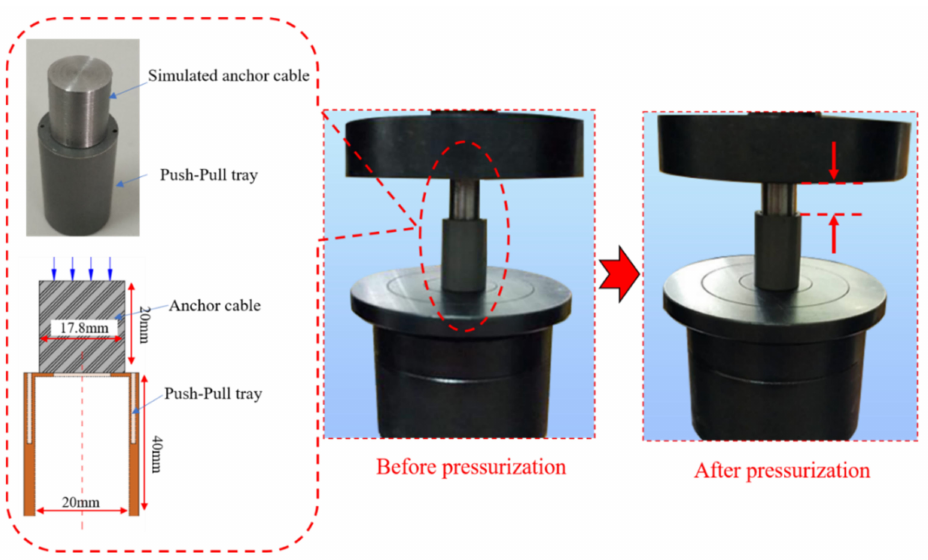
Figure 12. Mechanical loading test of push–pull tray.